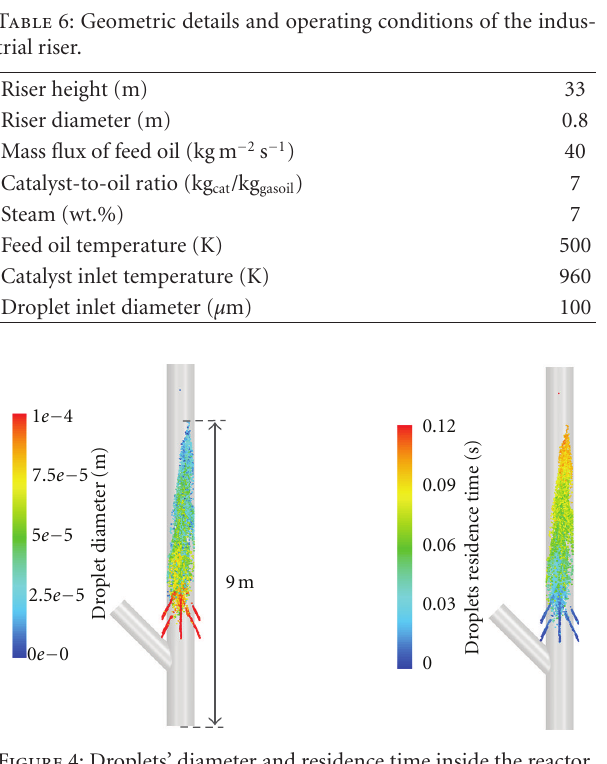
Figure 4: Droplets’ diameter and residence time inside the reactor.